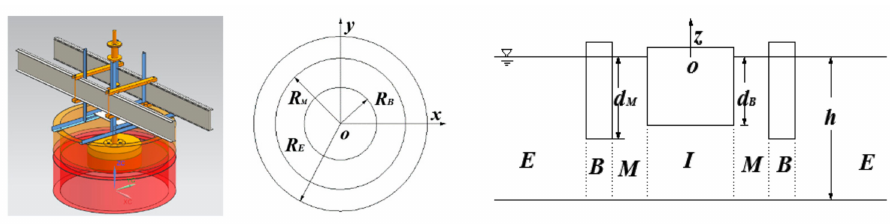
Figure 1. Moonpool platform–wave energy buoy